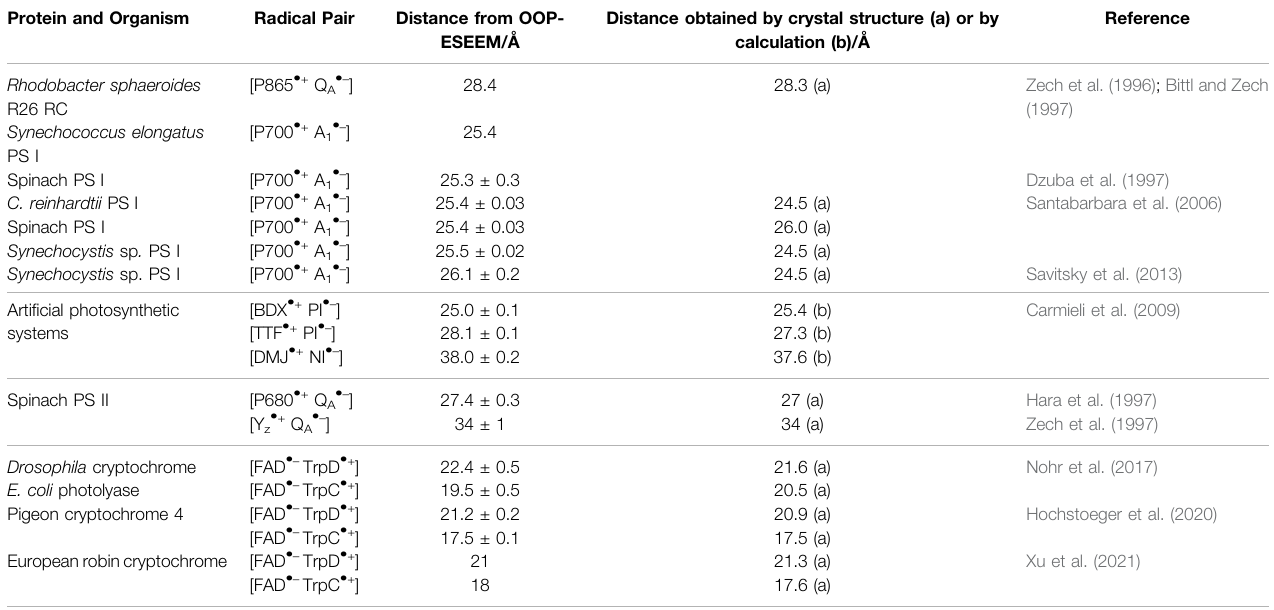
TABLE 1| Radical pair distancesin various protein systems determined using OOP-ESSEM and comparison tothe respectivedistancesobtained from crystal structuresor structure models. Protein and Organism Radical Pair Distance from OOP- Distance obtained by crystal structure (a) or by ESEEM/Å calculation (b)/Å